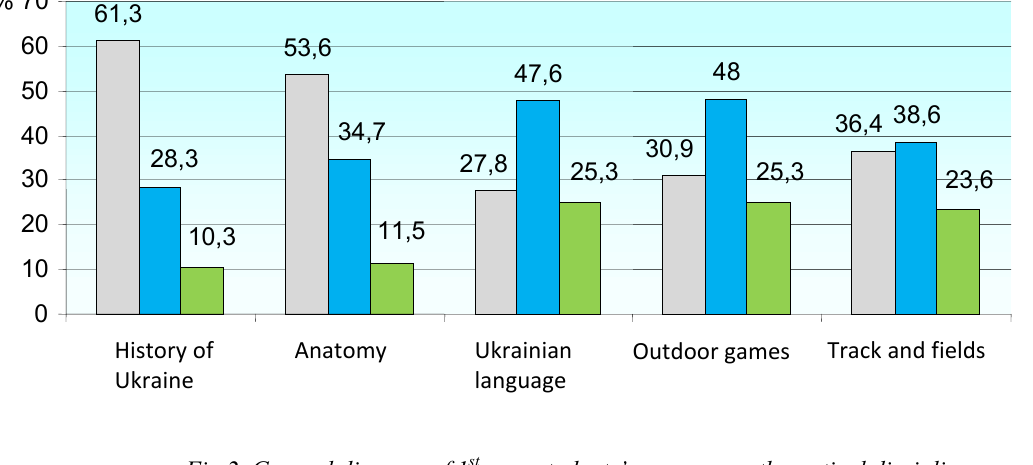
Fig.2. General diagram of 1 st year students’ progress on theoretical